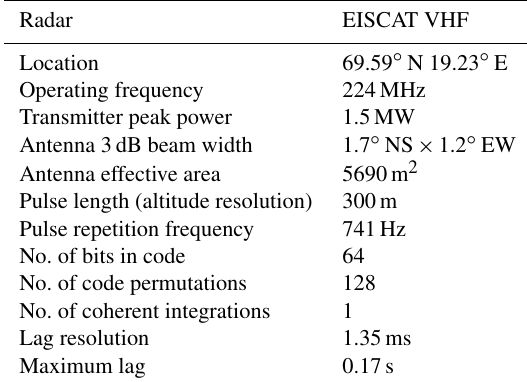
Table 1. Parameters of the